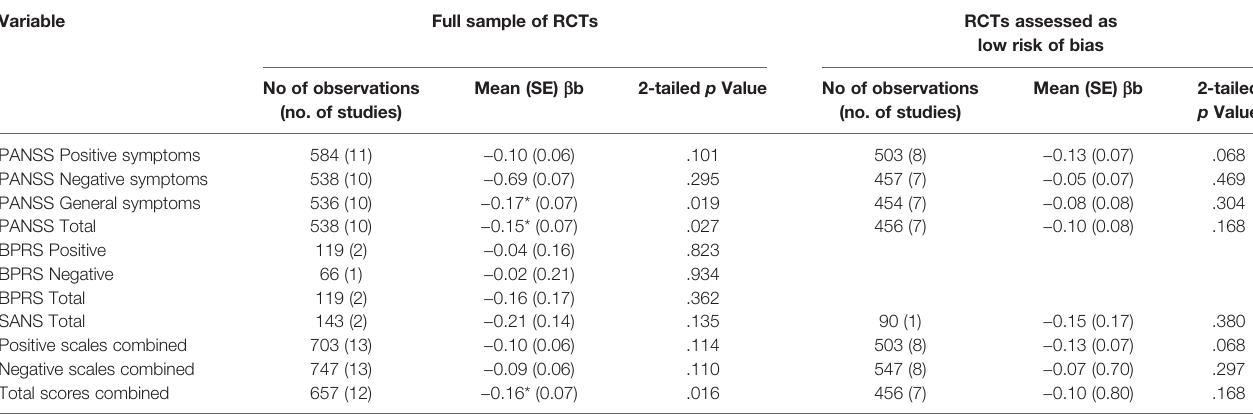
TABLE 2 | Individual participant data main effects of CBTp versus other interventions pooled.